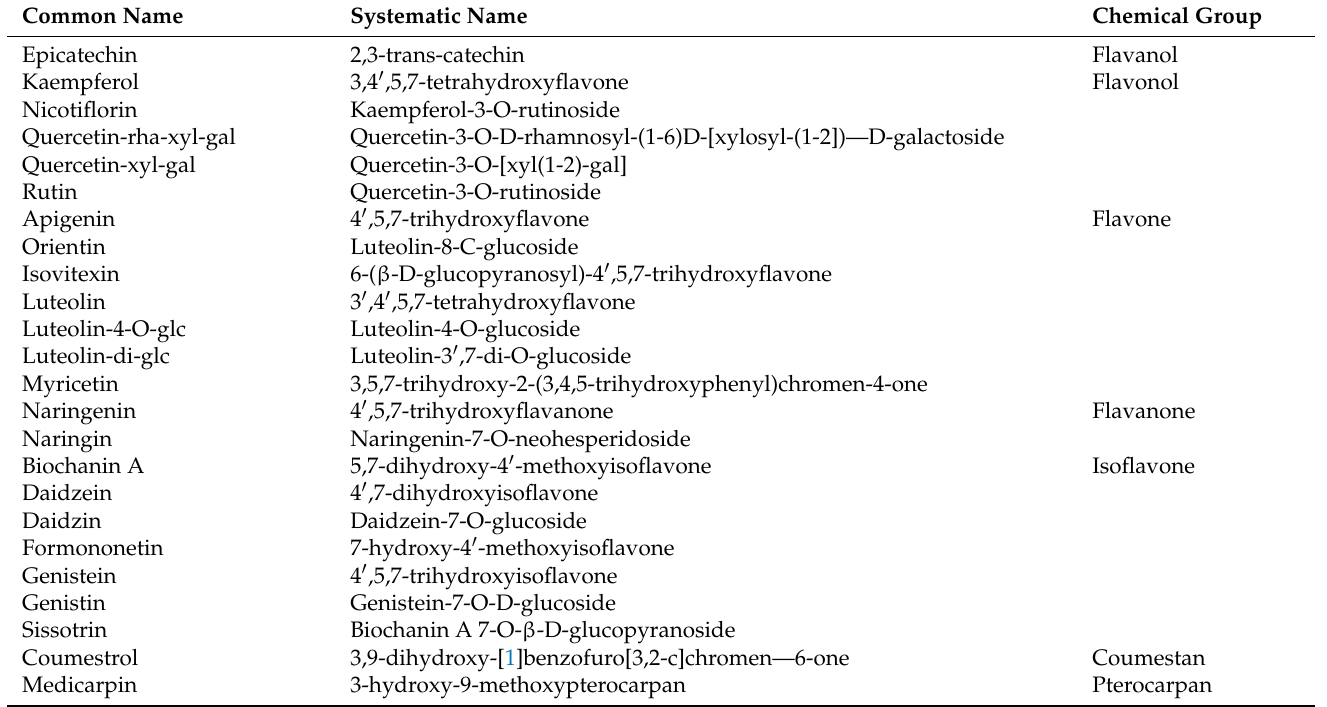
Table 1. Names and classification of flavonoid compounds quantified in Campanula portenschlagiana